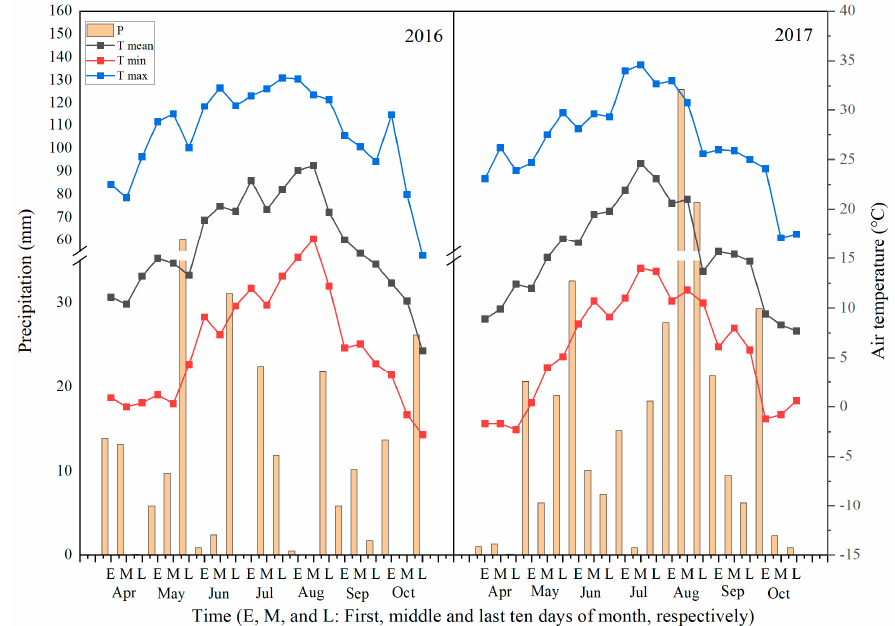
Figure 1. Ten-days (the first, middle, and last ten days) precipitation from April to October at the experimental site (P, in mm), mean air temperature (T mean), maximum (T max) and minimum air temperature (T min, all in °C) from April to October, in 2016 and 2017.